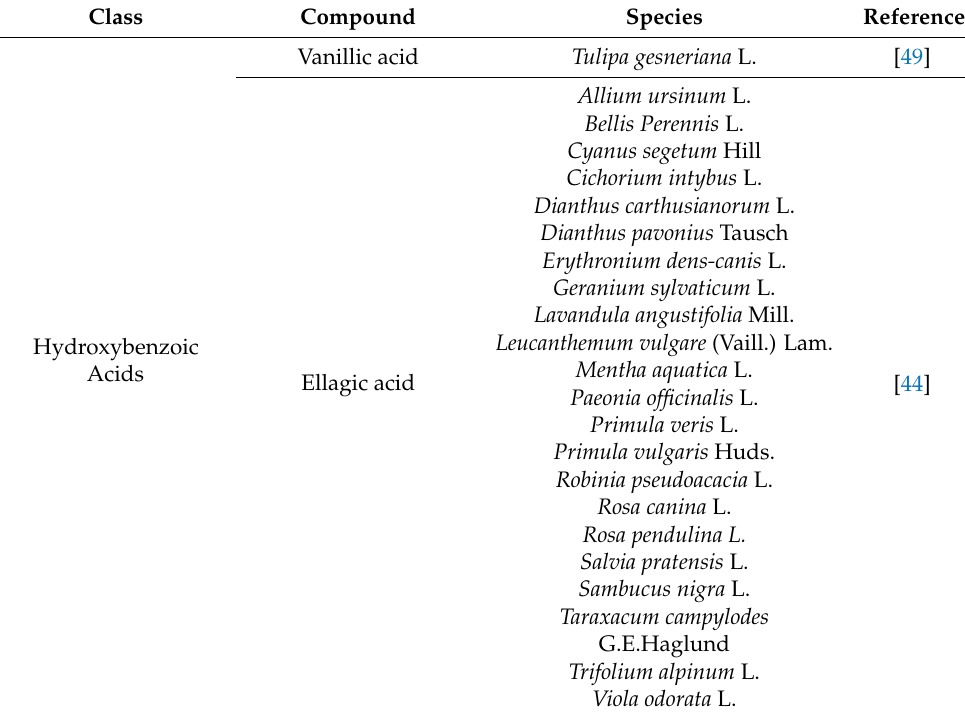
Table 1. The main phenolic acids commonly found in edible